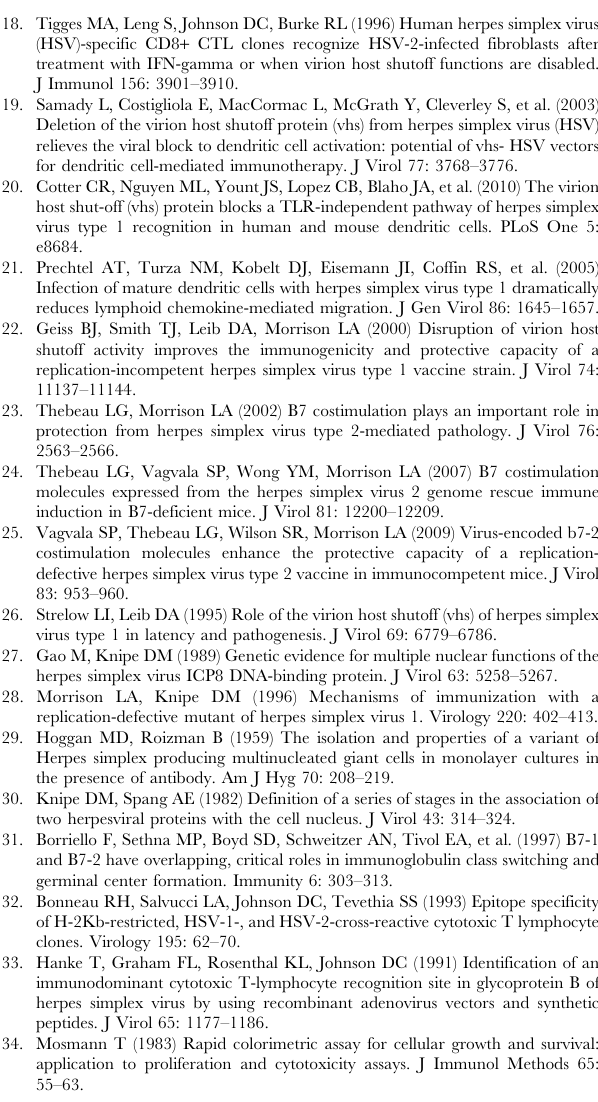
Figure S3 IFN c -producing T cells responding to challenge. Groups of BALB.B mice were immunized with the medium dose of the indicated replication-defective virus or control supernatant. One month later mice were challenged by infected via the cornea with HSV-1. Four days post-challenge, mononuclear cells from the cervical lymph nodes were stimulated in vitro with A and B) UV- inactivated HSV-1, or C and D) 0.2 m M of gB498–505 peptide and analyzed in an IFN c ELISpot assay. Data were compiled from 3 independent experiments with UV-inactivated virus stimulus for from 4 independent experiments with peptide stimulus for a total number of 12 to 14 mice per group. *, P , 0.05 to 0.01 for D 41 D 29 compared with D 41 D 29B7-2. Figure S4 Acute replication of challenge virus in the nervous system of BALB.B mice. BALB.B mice were immunized with the medium dose of the indicated virus or with control supernatant and challenged by the corneal route one month later. TG and brainstems were dissected 4 d post-challenge, and virus titer in them was determined by standard plaque assay. Data